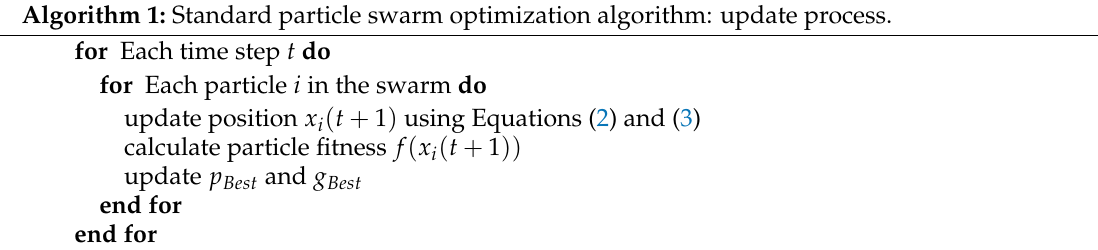
Algorithm 1: Standard particle swarm optimization algorithm: update